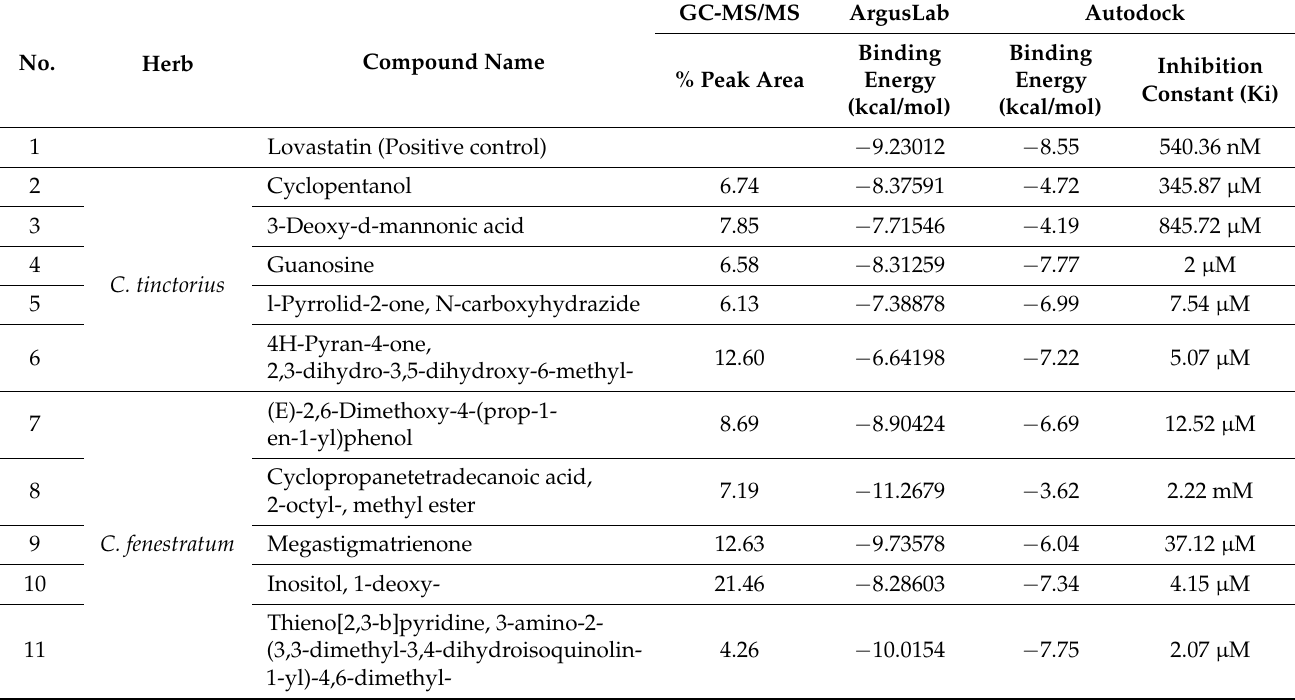
Table 14. Energy binding and phytochemical inhibition constants of herbal extracts with ethanol at the binding sites of HMGR from ArgusLab and Autodock analysis and quantification of each compound through GC-MS/MS